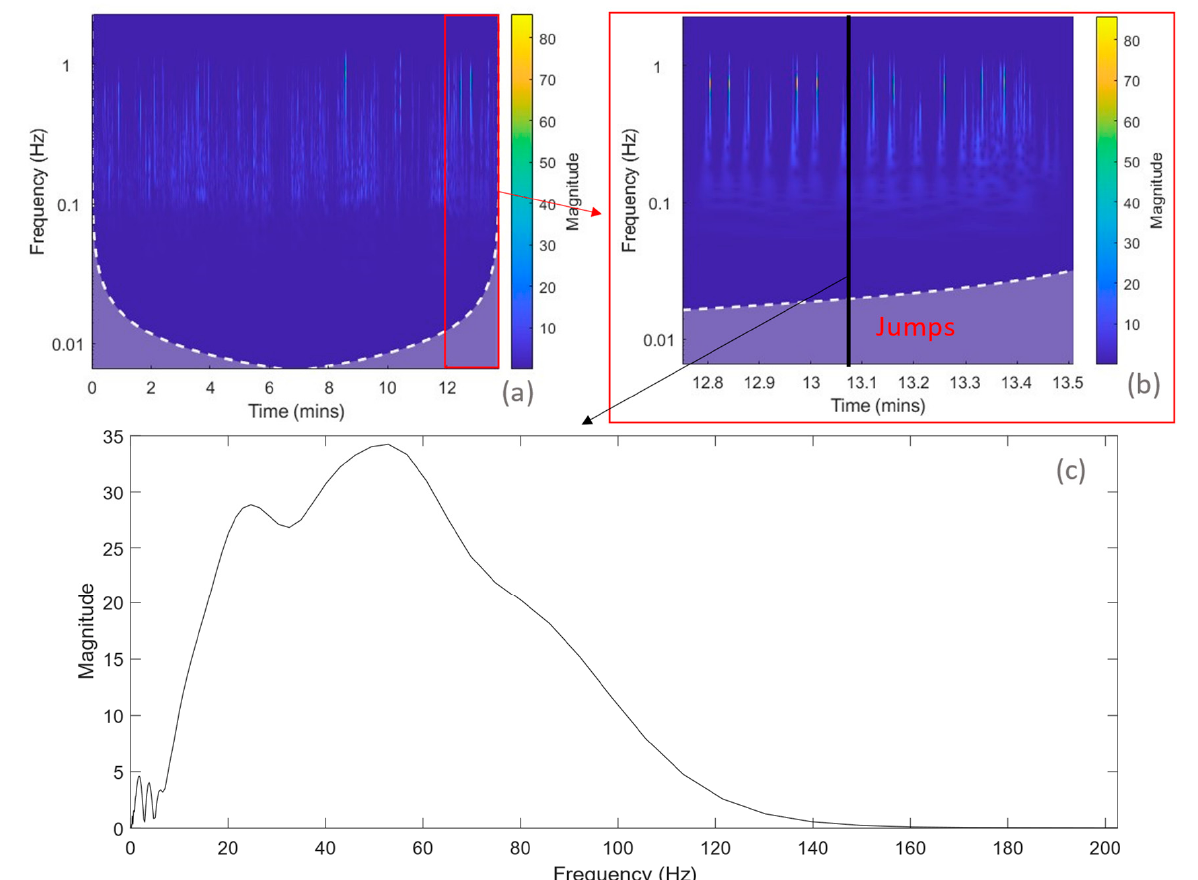
Figure 11. ( a ) CWT of acceleration data of the left foot for optimal DA orientation. The Morse wavelet was selected for visualization. ( b ) Partial visualization of the CWT for illustrating the frequency components present in jumps. ( c ) Temporal frame of the frequency spectrum of an impact caused by a jump. This fi gure shows the frequency spectrum repartition for a fi xed time.